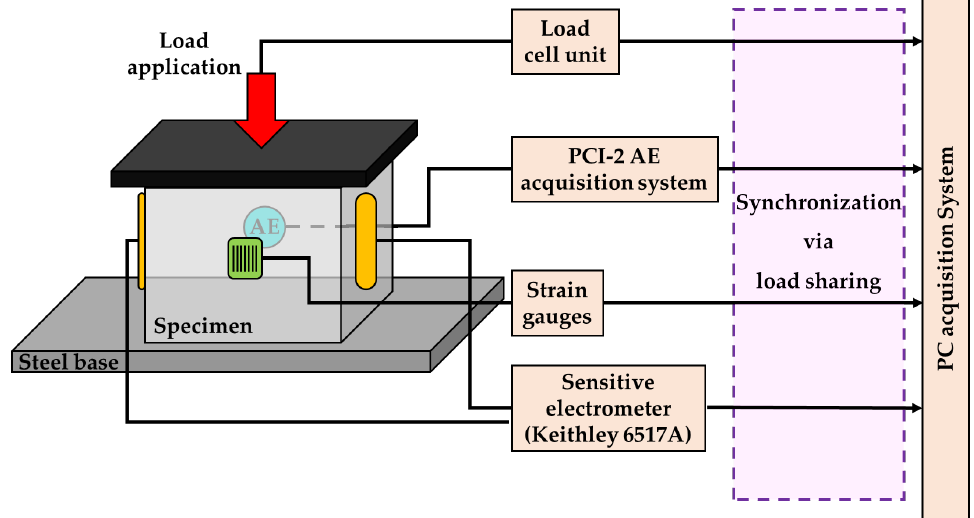
Figure 1. The experimental set-up for the concurrent recordings of the axial deformation, the PSC and the AE.